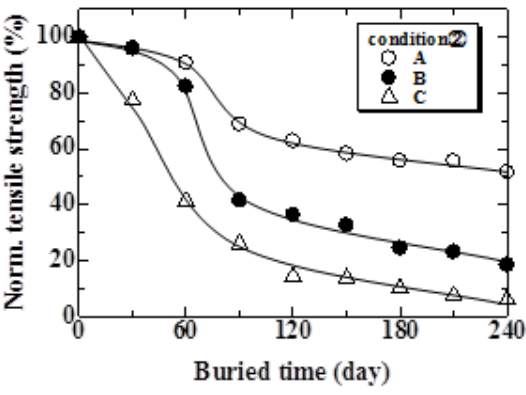
Figure 7. Relationship between normalized tensile strength and burial period under Condition 2.